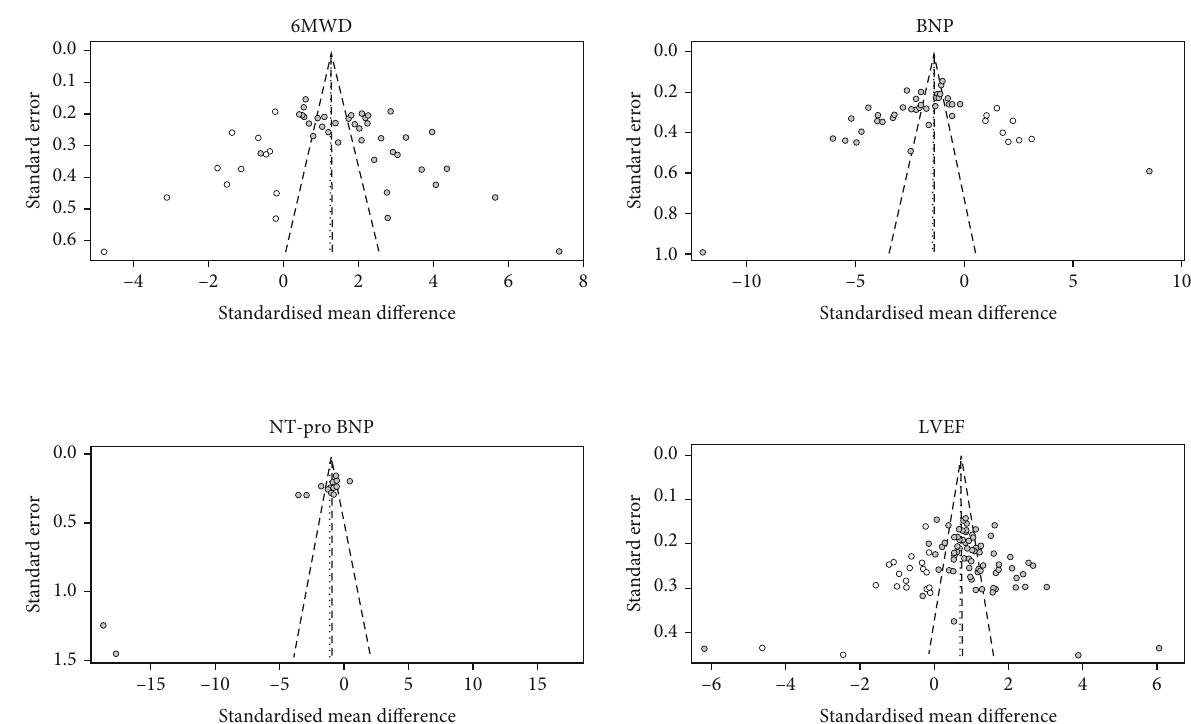
Figure 5: Filled funnel plots for all the